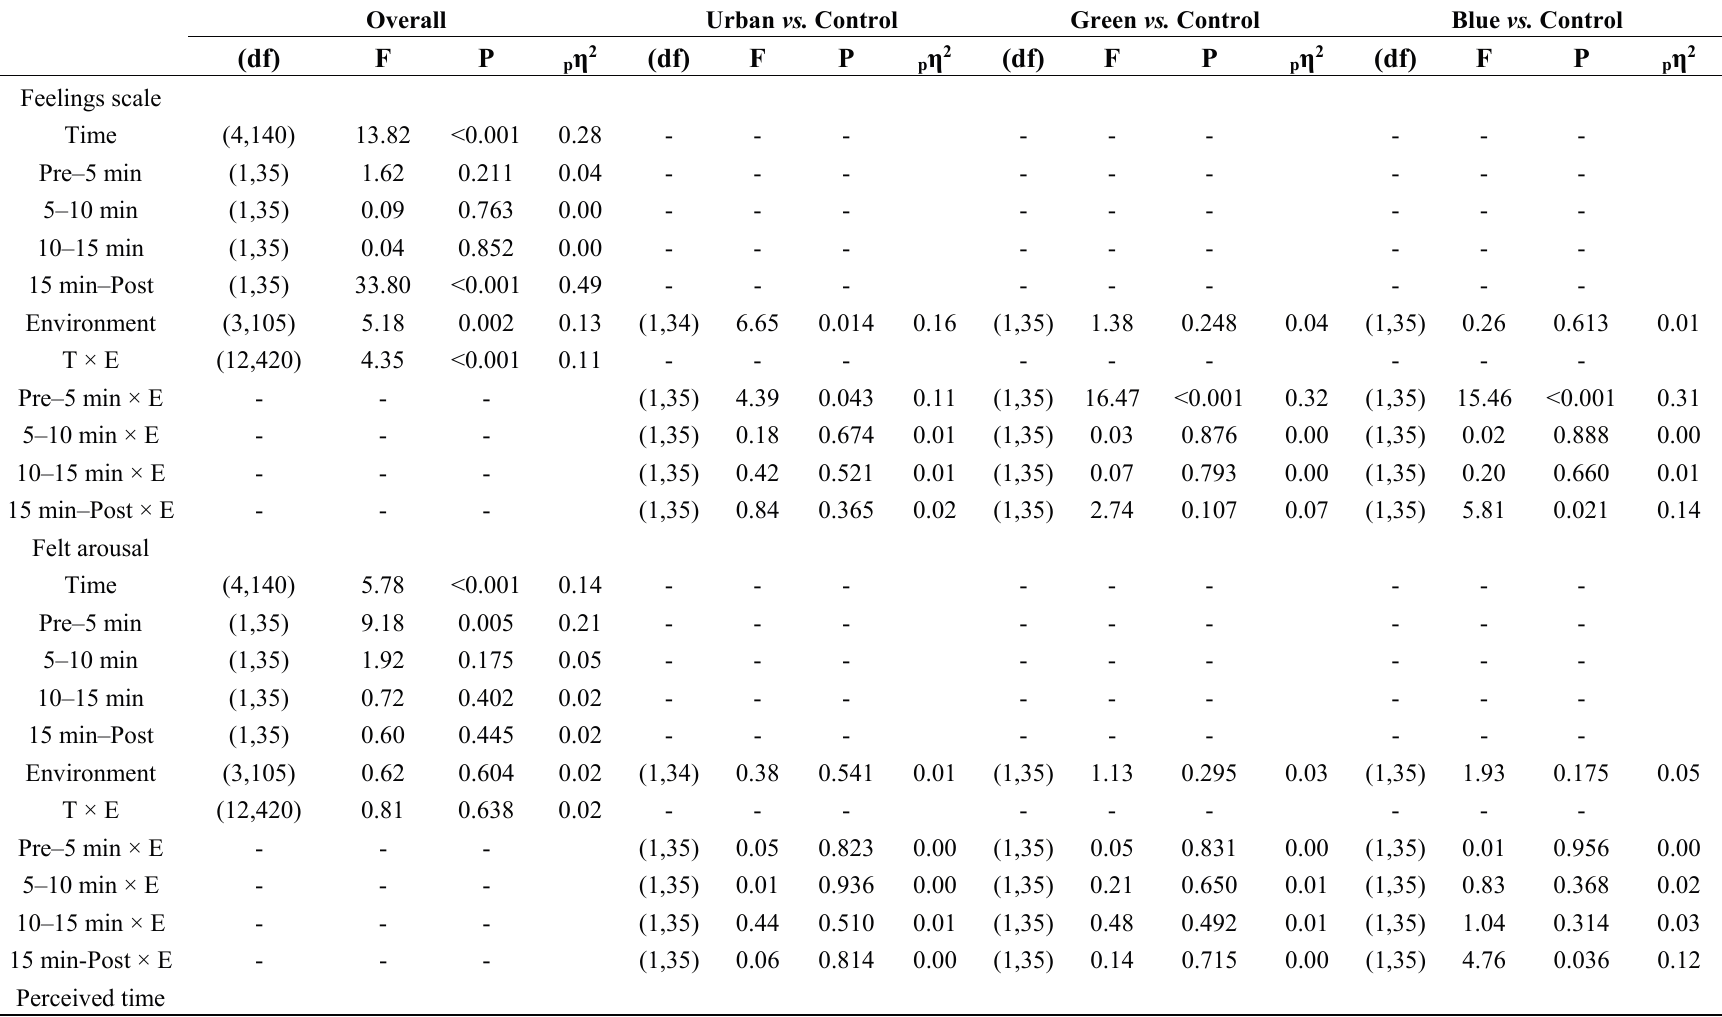
Table 4. Results of ANOVAs with planned contrasts for psychological variables: Repeated for Time, Simple for Environment (with Control as comparator), and Repeated × Simple for Time by